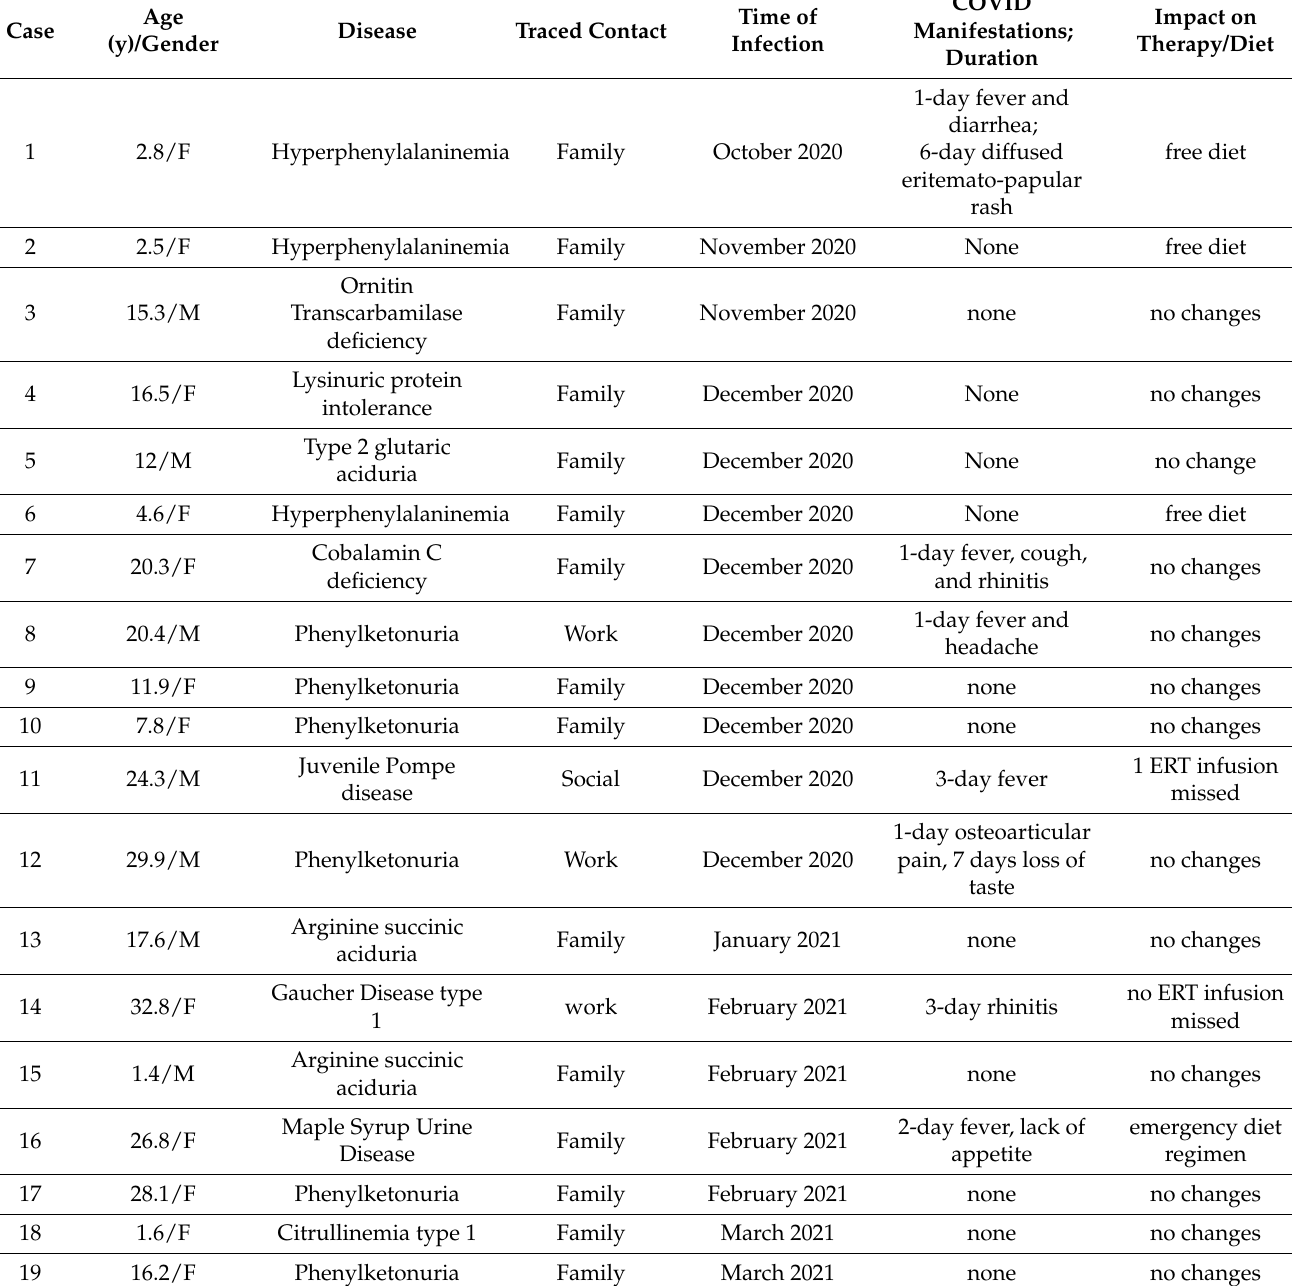
Table 1. Patients and infection